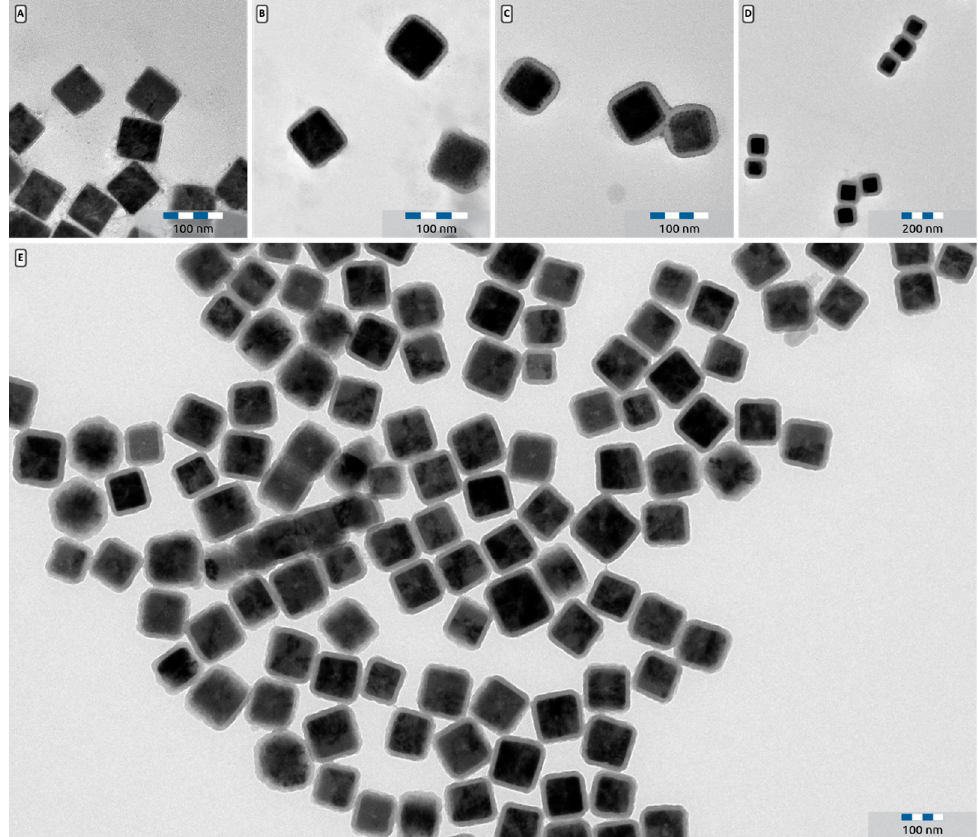
Figure 6. ( A ) TEM picture of Cu 2 O@SiO 2 core-shell particles with a 6 nm shell. ( B ) TEM picture of Cu 2 O@SiO 2 core-shell particles with a 9 nm shell. ( C ): TEM picture of Cu 2 O@SiO 2 core-shell particles with a 13 nm shell. ( D ) TEM picture of Cu 2 O@SiO 2 core shell particles with a 21 nm shell. ( E ) Low magnification TEM image of Cu 2 O@SiO 2 core-shell particles with a 13 nm shell that shows the uniform thickness of the silica shell.